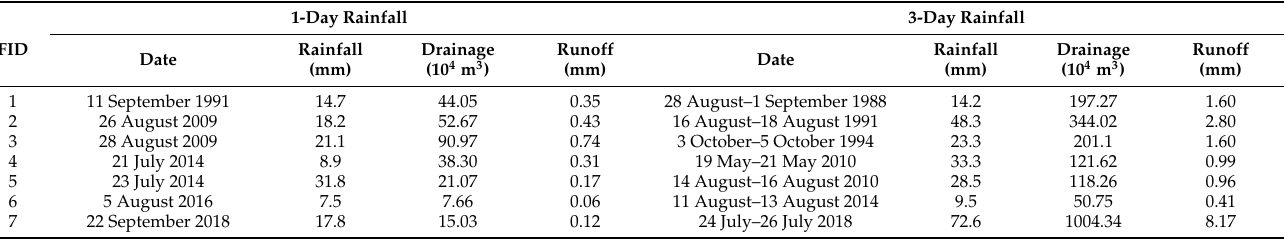
Table 1. Observed runoff under different rainfall